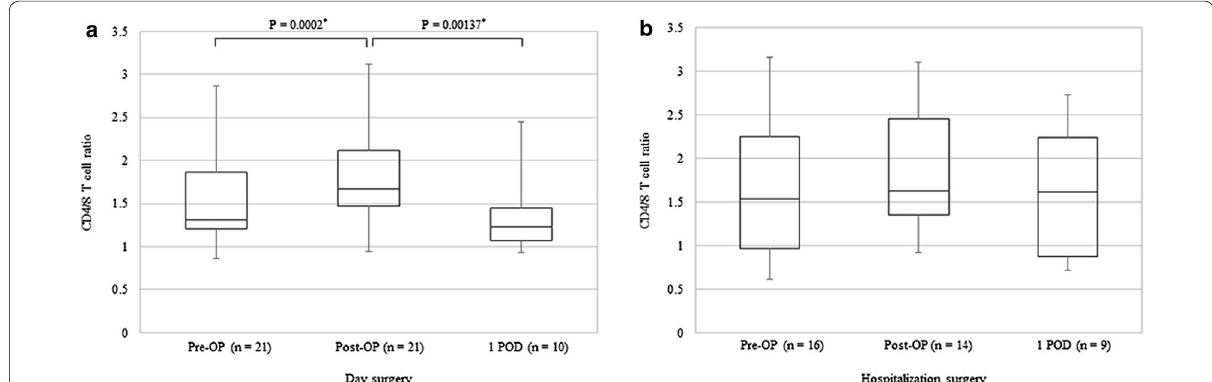
Fig. 3 Changes in CD4/8 T cell ratio before surgery, after surgery, and on the first postoperative day in patients undergoing day surgery ( a ) versus hospitalization surgery ( b ) for breast cancer. Median values are expressed with interquartile ranges in the box plot. *P < 0.05 versus after surgery and on the first postoperative day (Wilcoxon matched pairs test). Pre-OP before operation, Post-OP after operation, 1 POD first postoperative day